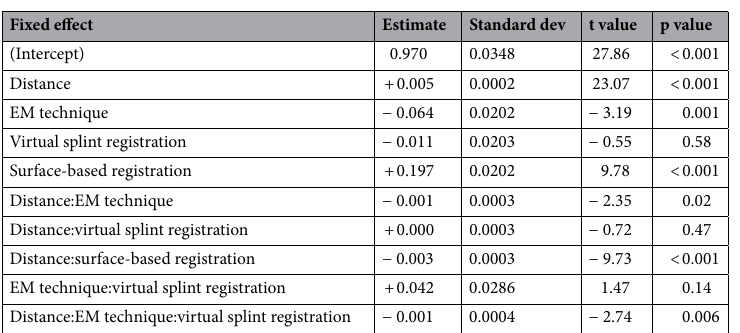
Table 3. Fixed-effect estimates. Bone-anchored registration with optical navigation was used as the reference